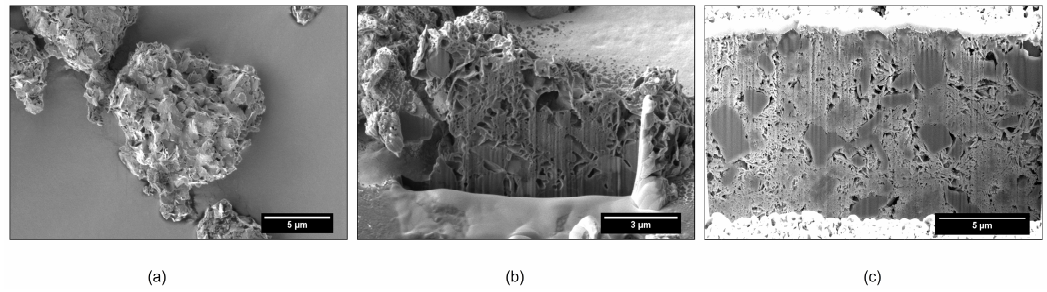
Figure 3. Visualization of unloaded FCC; ( a ) SEM analysis of an individual FCC particle; ( b ) focused ion beam scanning electron microscopy (FIB-SEM) based visualization of a cross section of an individual particle; ( c ) unloaded FCC after consolidation at 37 MPa.